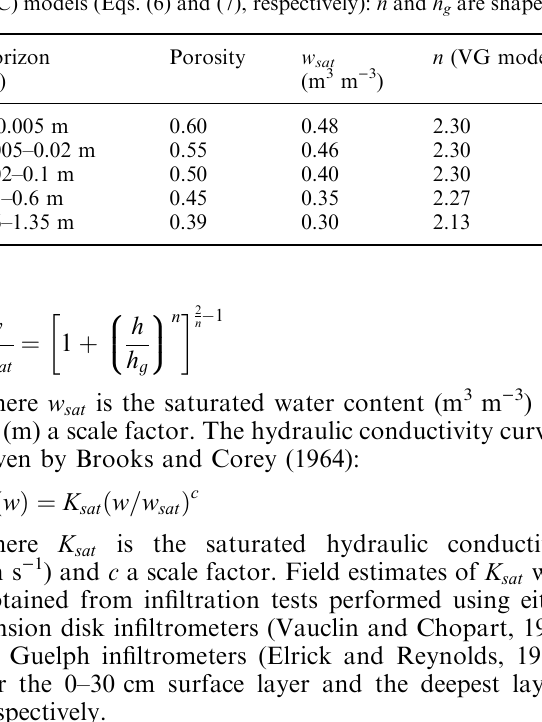
scale parameters of the VG model, and c is the shape parameter of the BC model. The thermal conductivity k is given by Eq. (8) below 0.02 m. The saturated water content and hydraulic conductivity are are shape and and K , denoted by w g sat sat